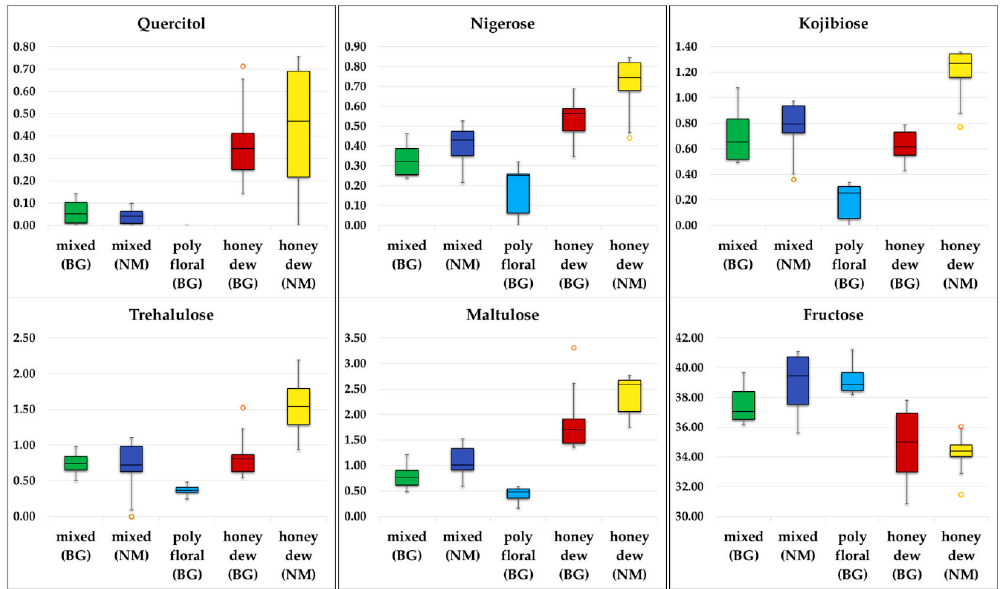
Figure 6. Box plot presentation for quercitol, nigerose, kojibiose, trehalulose, maltulose and fructose.